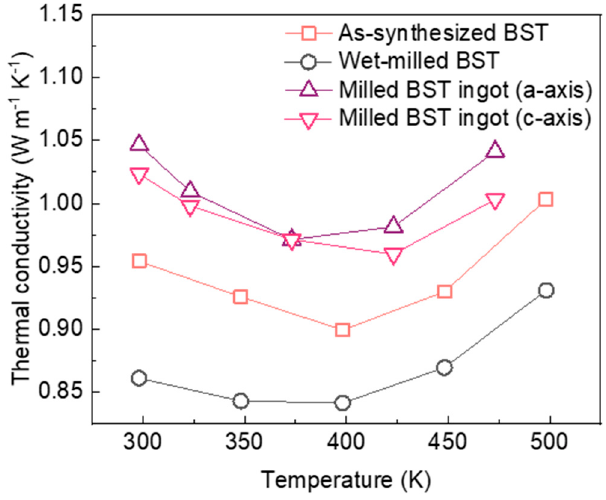
Figure 7. Temperature-dependent κ of the as-synthesized BST, post-wet-milled BST, and the BST ingot as the axes.